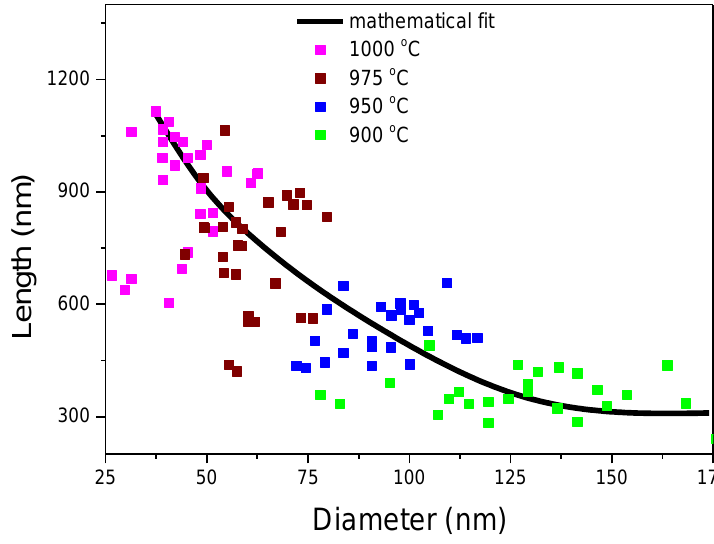
Figure 2. GaN NR length versus diameter distribution as a function of temperature (2 h growth on Si).